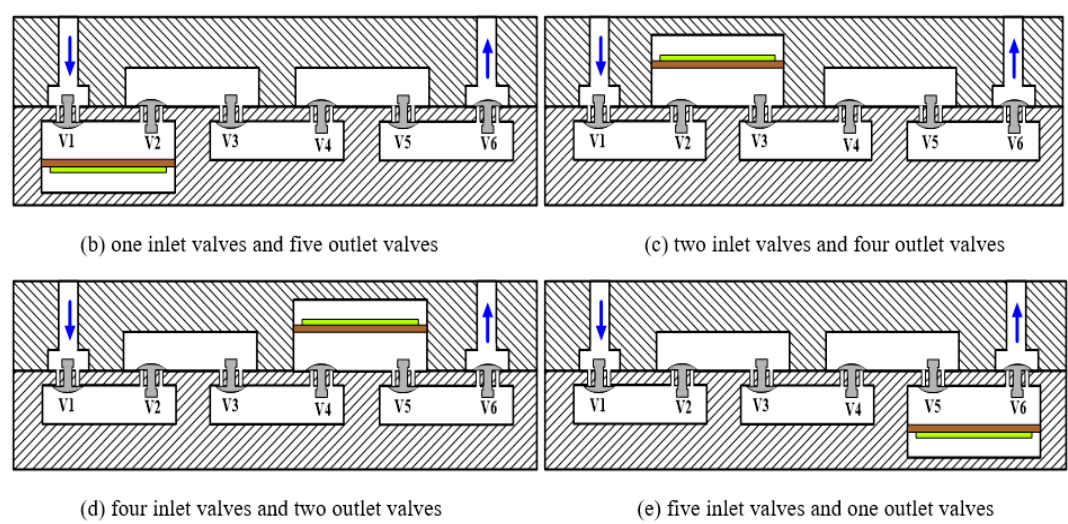
Figure 2. The demonstration structure of a single-active-chamber piezoelectric membrane pump with multiple passive check valves.